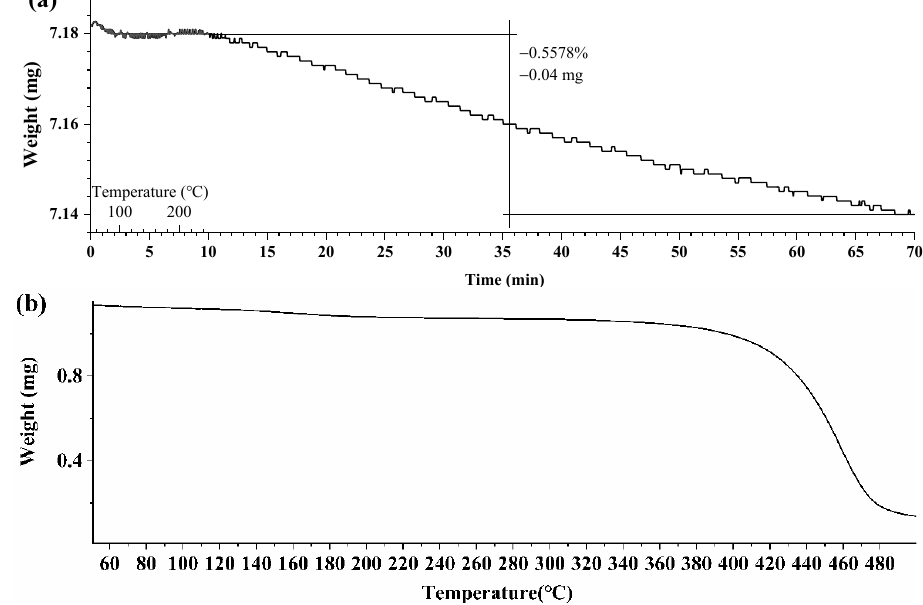
Figure 2. TGA of prepared DVB/Carbon/PDMS SPME fiber: ( a ) temperature programming: initial temperature 50 °C, heating rate 20 °C/min, 20~70 min, constant temperature 250 °C; ( b ) temperature range: 50 °C~500 °C.